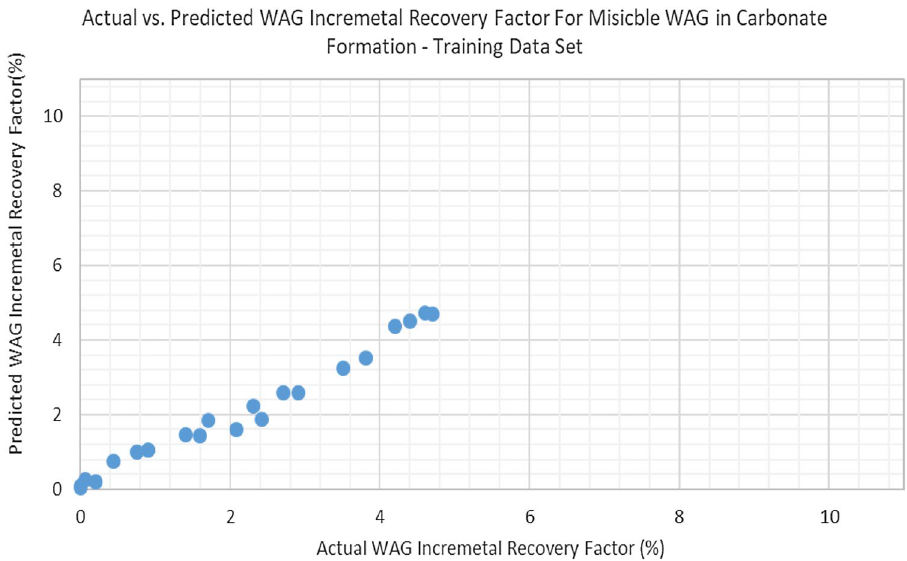
Fig. 17 GMDH WAG incre- mental recovery factor predic- tion model validation results for miscible WAG in sandstone